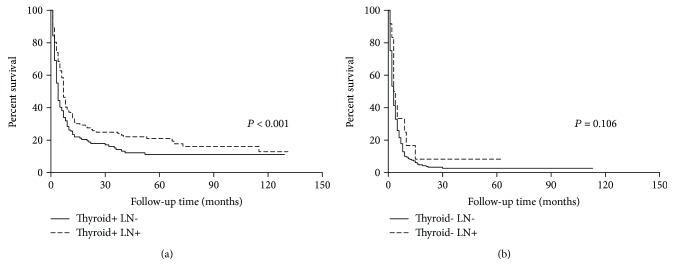
(a) In patients who had thyroid surgery, cervical lymph node dissection could improve patient survival, (b) while in patients without thyroid surgery, the survival benefit of lymph node dissection disappeared.